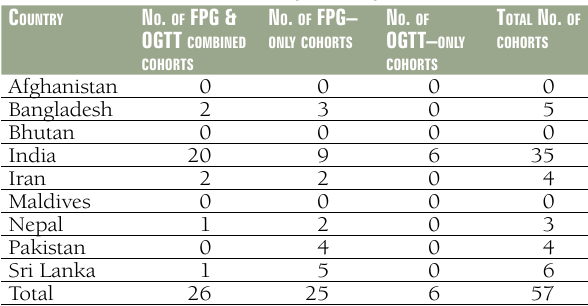
Table 6. Cohort characteristics by country C ountry n o . of fPG & oGtt CombineD